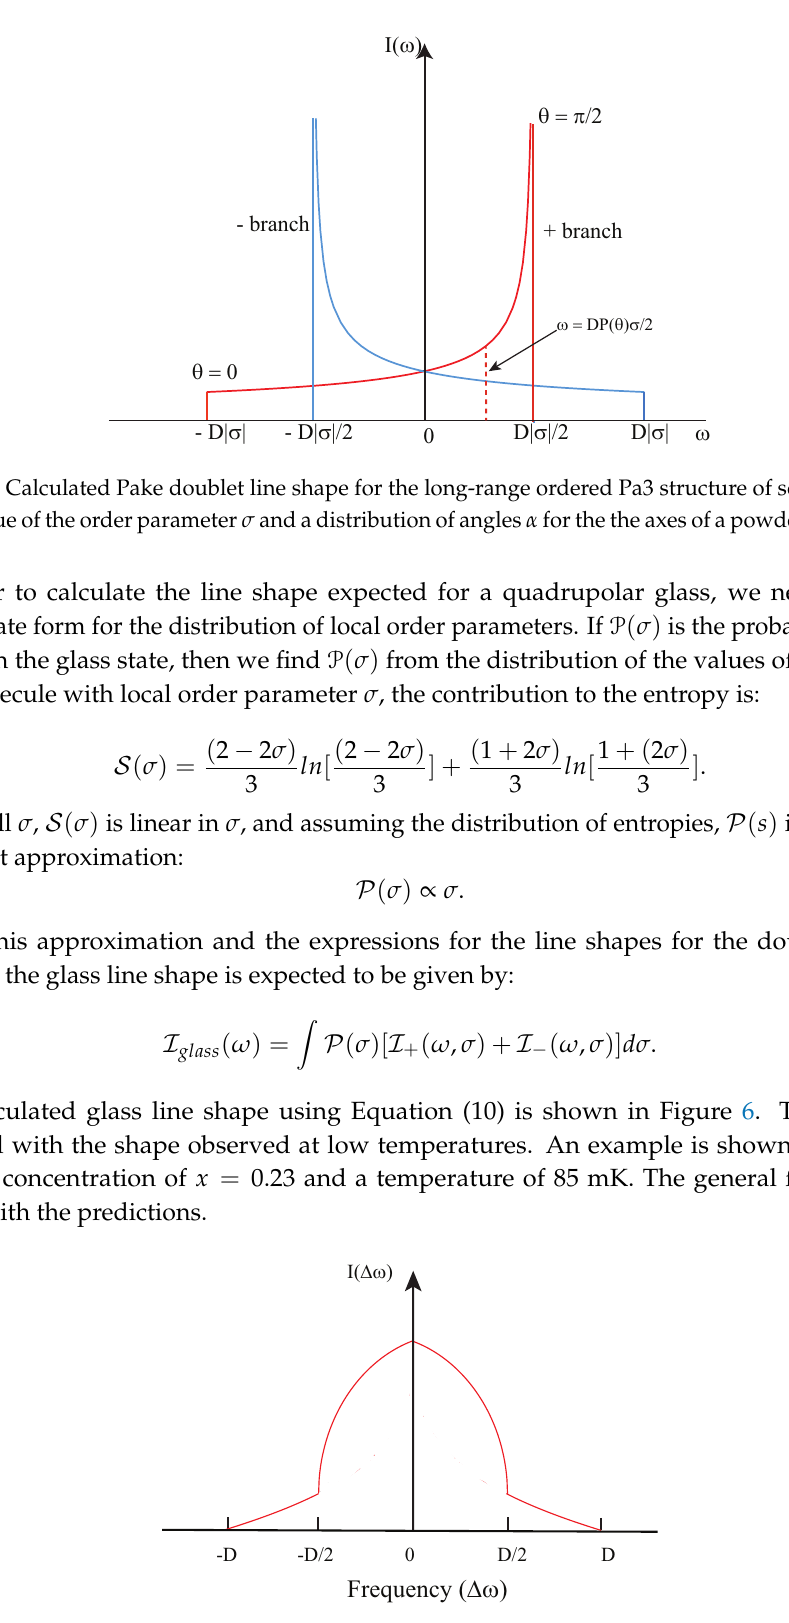
Figure 6. Calculated NMR line shape for quadrupolar glass state of solid H 2 for a broad distribution of order parameters σ . Reproduced with permission from [27]. Copyright Springer Nature,